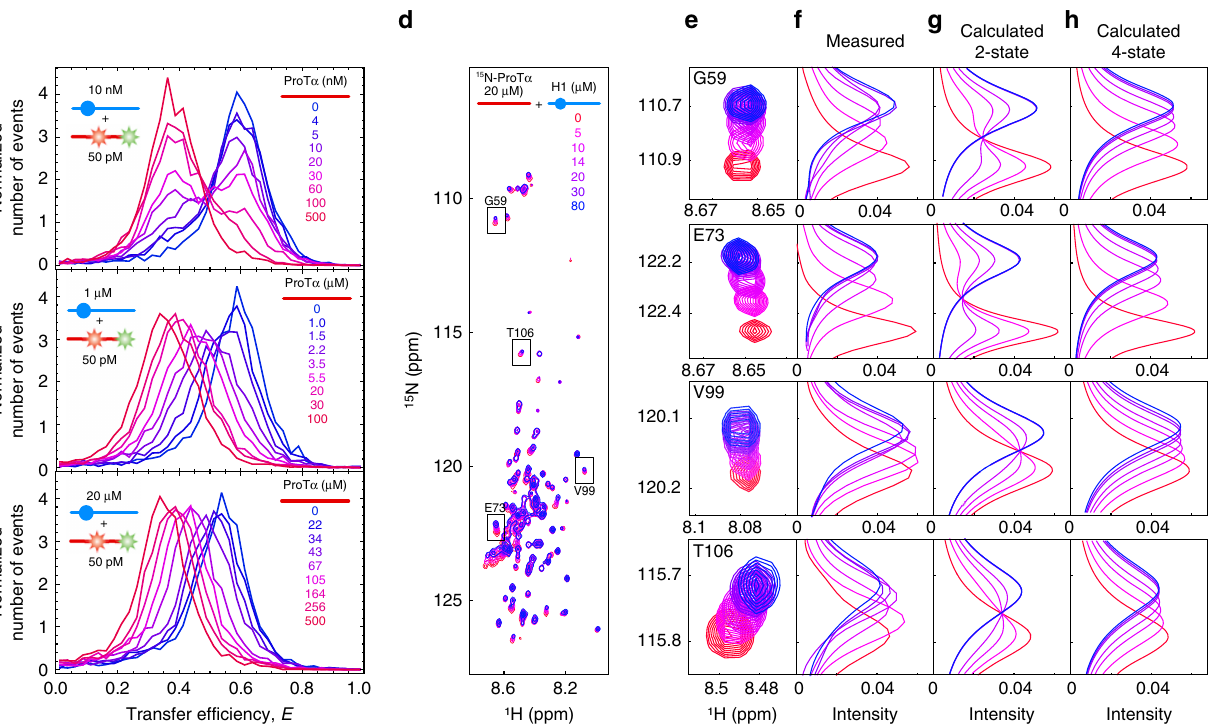
Fig. 2 Association/dissociation kinetics are highly protein concentration-dependent. a – c Overlay of transfer ef fi ciency histograms of 50 pM ProT α E56C/D110C labeled with Alexa Fluor 488/594 at different concentrations of unlabeled H1 (10 nM, 1 μ M, and 20 μ M) titrated with increasing concentration of unlabeled ProT α exhibit a transition from slow to fast exchange between the populations (see legends for color code). The mean transfer ef fi ciency of bound ProT α decreases slightly with increasing H1 concentration owing to the formation of higher-order complexes (Supplementary Fig. 3d). d 1 H – 15 N-HSQC spectra of 20 μ M 15 N-ProT α (recorded at 750 MHz and 200 mM ionic strength) titrated with increasing concentrations of unlabeled H1 (see legend for color code). e Examples of individual resonances illustrate the continuous shifting of a single population-averaged peak. f 1D 15 N projections of the NMR resonances at different concentrations of unlabeled H1. g , h Comparison of NMR 1D 15 N lineshapes calculated using the Bloch – McConnell equation for a two-state ( g ) or a four-state binding mechanism ( h ) (see Supplementary Table 2 for rate coef fi cients and “ Methods ” for